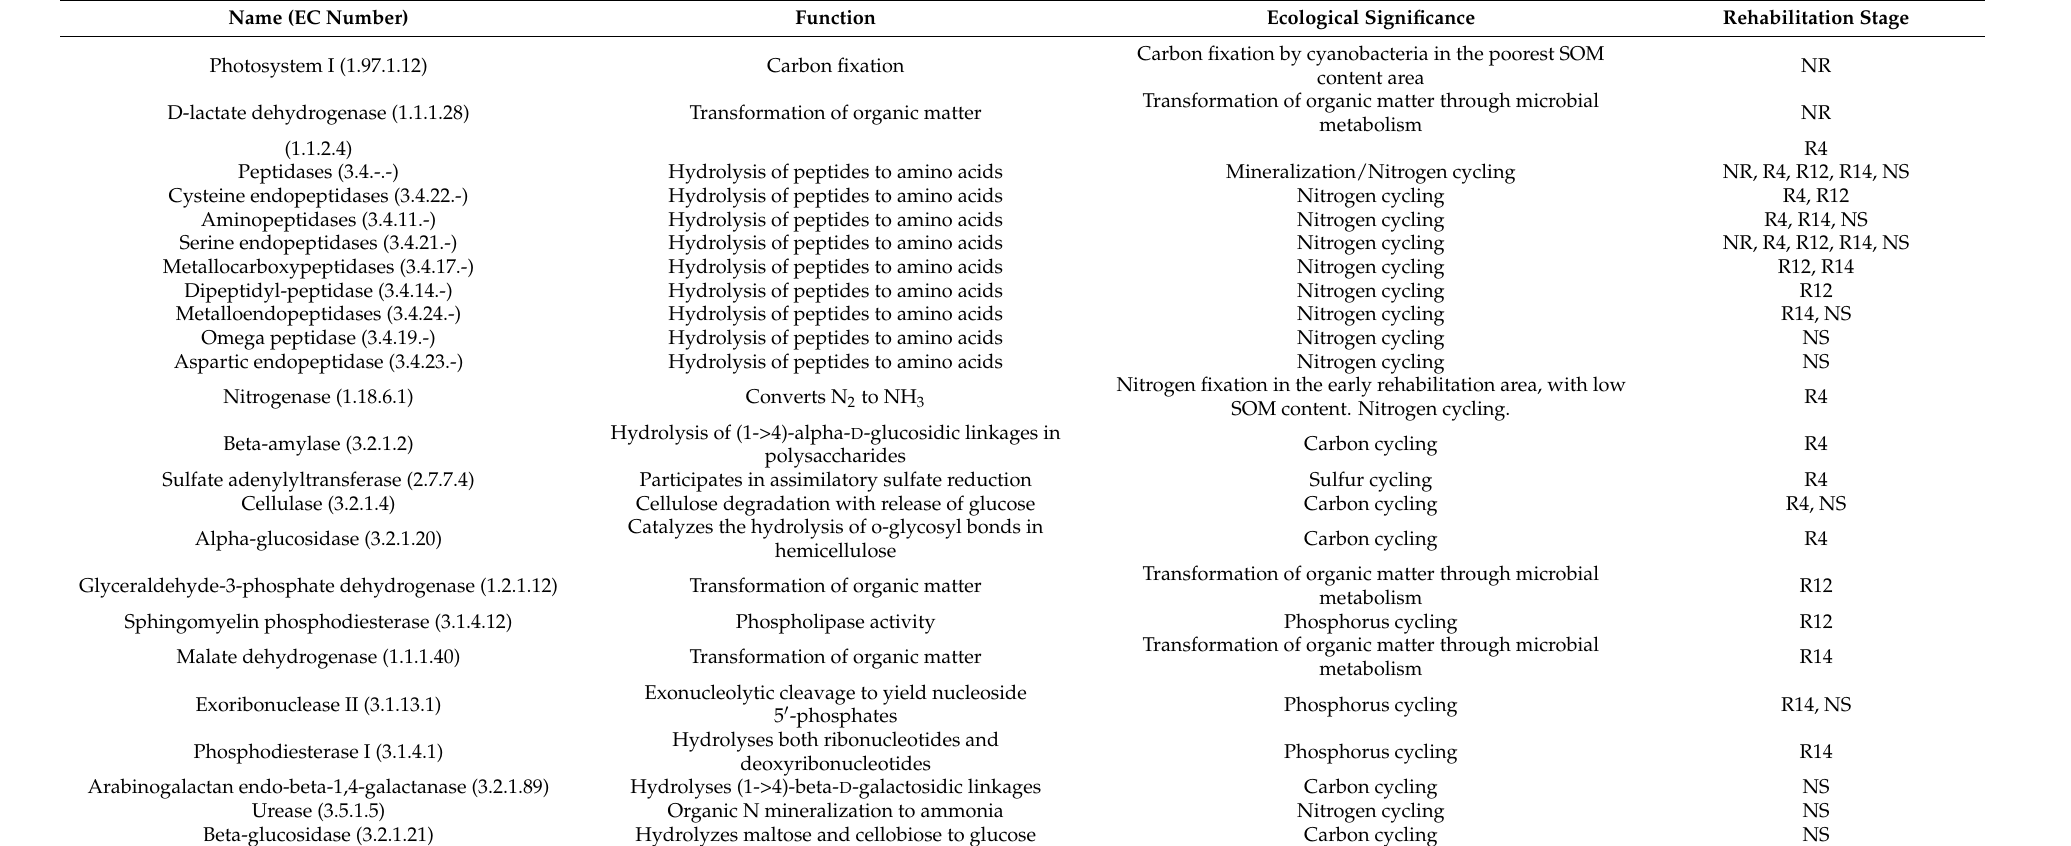
Table 4. Enzymes involved in nutrient cycling and SOM transformation found in the present